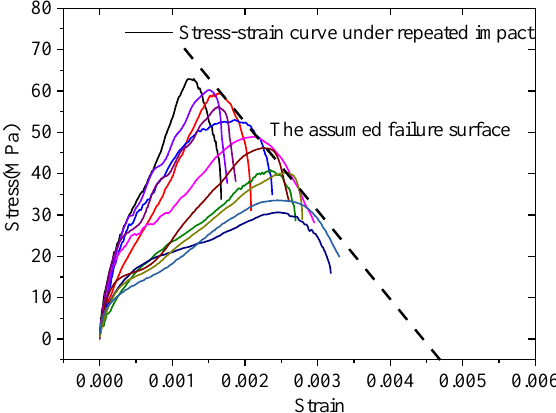
Figure 19. The failure strain under repeated impacts. Table 8. The parameters of the HJC model for sandstone.